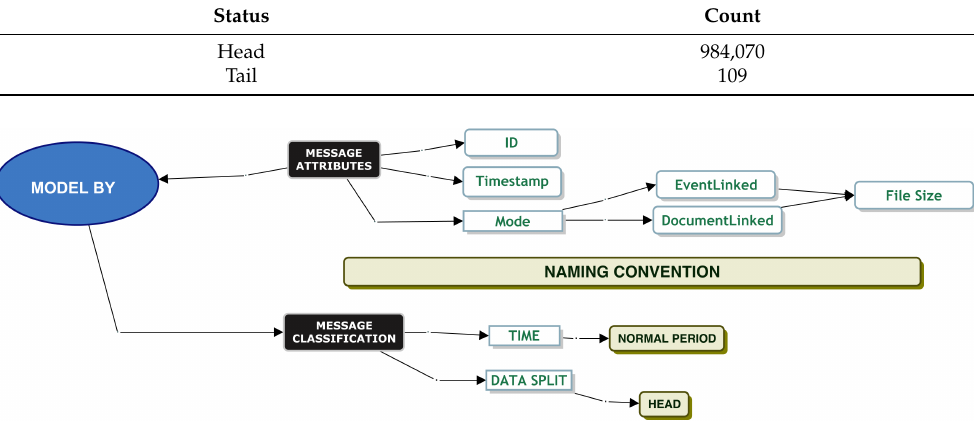
Figure 7. File size